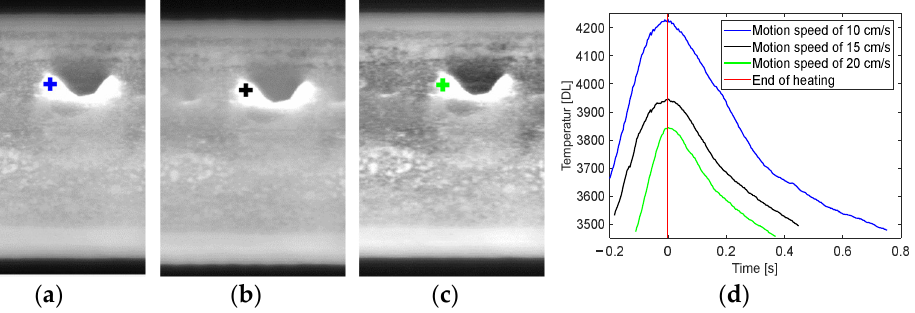
Figure 17. Evaluation of points in the transformed image for measurements with ( a ) 100 mm/s; ( b ) 150 mm/s; ( c ) 200 mm/s; ( d ) time vs. temperature graph of the three evaluated points.